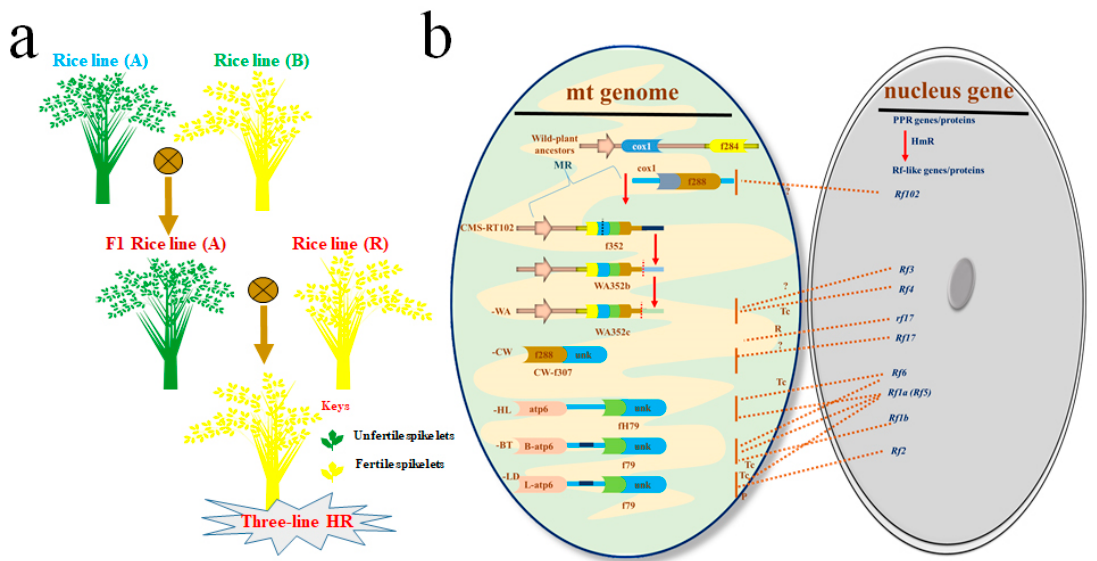
Figure 1. Three-line hybrid-rice technology. ( a ) Three-line HR technology works through three different rice lines, as rice-line A (cytoplasmic-male-sterile line), rice-line B (maintainer line), and rice-line R (restorer line). ( b ) The regulatory factors that can restore rice fertility. Several sequences of the mitochondrial (mt) genome undergo multirecombination (MR) through evolution in rice to generate structural mutations. The flow of sub-stoichiometric due to the variations in copy number of a gene and leading to the emergence of a functional cytoplasmic-male-sterile (CMS) gene. Expanding clusters of the pentatrico-peptide repeat resulted in functional-Rf alleles used for cytoplasmic-male-sterility restoration. The nucleus genes as Rf converse function of CMS gene(s) at transcriptional (Tc) and/or protein (P) levels, but the recessive allele like rf17 is retrogradely (R) upregulated through CMS gene(s). In the figure, MR, HmR, PPR, f284, f288, f352, fH7, f79, -WA, -CW, -HL, -BT, -LD, and unk represent multi-recombination, homologous-recombination, pentatrico-peptide repeat, orf284, orf288, orf352, orfH7, orf79, CMS-WA, CMS-CW, CMS-HL, CMS-BT, CMS-LD, and unknown, respectively.